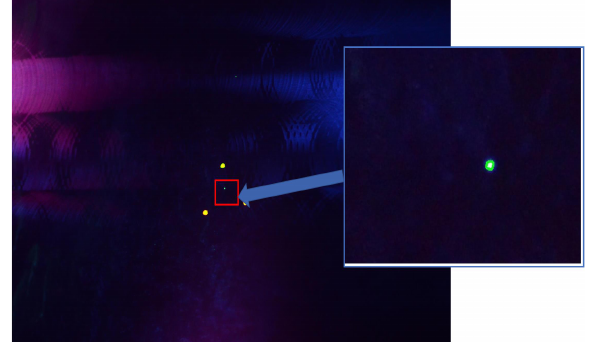
Figure 11. Image with possible defect.